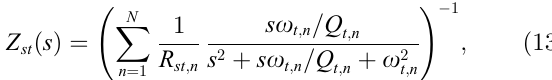
Figure 1. Controlled absorber. The two-input controller is depicted on the right in the dashed